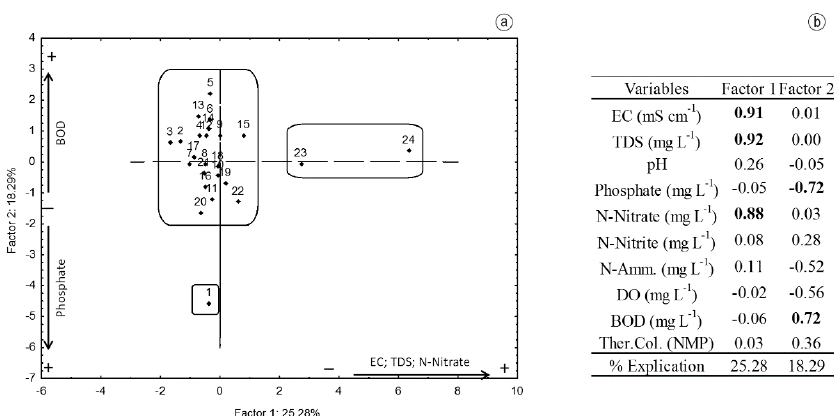
Figure 6. Principal Components Analysis of the sampling points of the Apodi/Mossoró river hydrographic basin, in the month of May of 2008. a) Representation of the two first PCA components; b) Variables correlation values. EC: Electric Conductivity; TDS: Total dissolved solids; N-Amm.: Ammoniacal nitrogen; DO: Dissolved oxygen; BOD: Biochemical Oxygen Demand; Ther. Col.: Thermotolerant Coliforms.